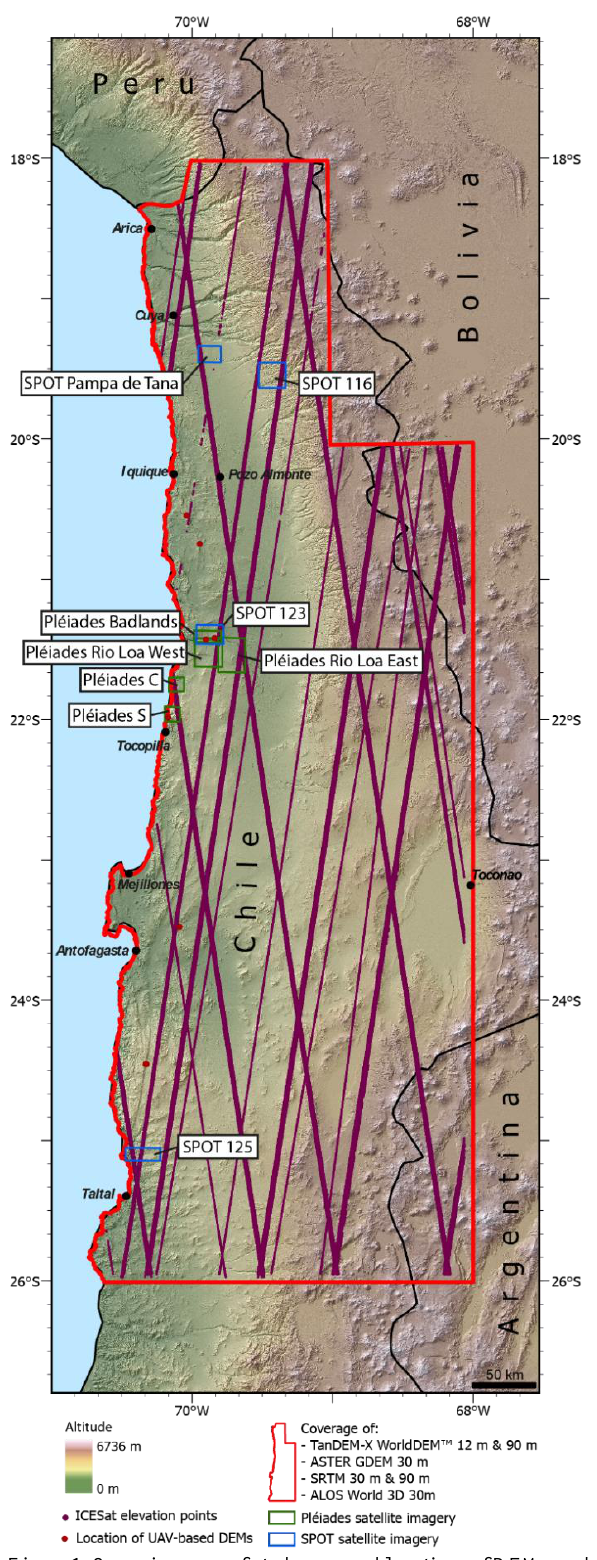
Figure 1. Overview map of study area and locations of DEMs and ground truth data. Map based on SRTM elevation